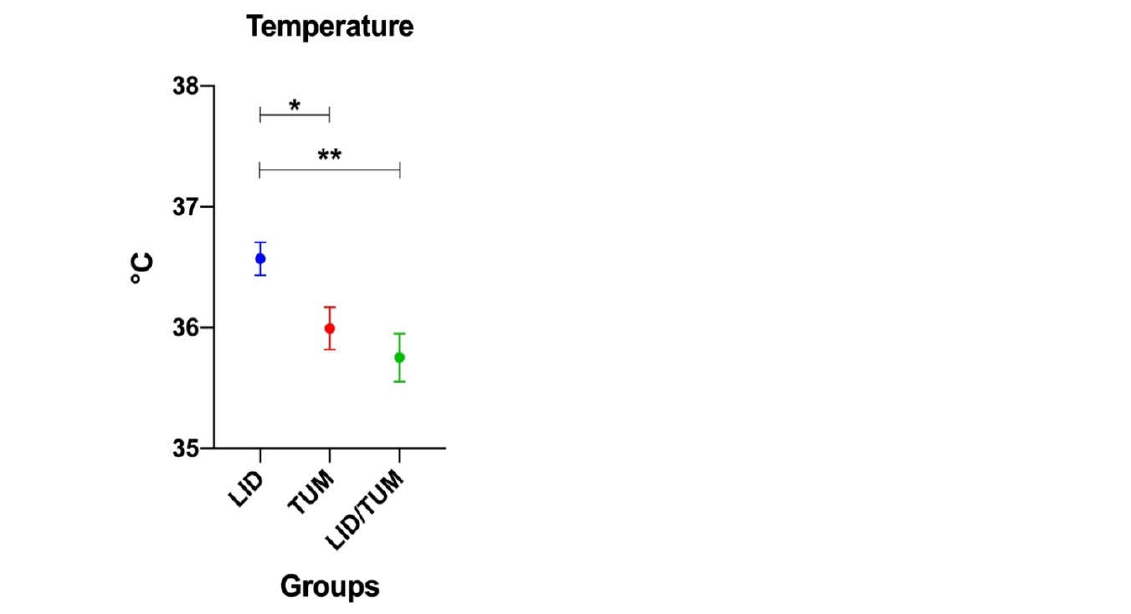
Figure 4. Mean values ± standard error of oesophageal body temperature during anesthesia pro- cedures in the three groups. LID: Lidocaine group; TUM: Tumescent anesthesia group; LID/TUM: Lidocaine/Tumescent anesthesia group. Asterisks indicate significant differences between groups: *: p < 0.05; **: p < 0.01.